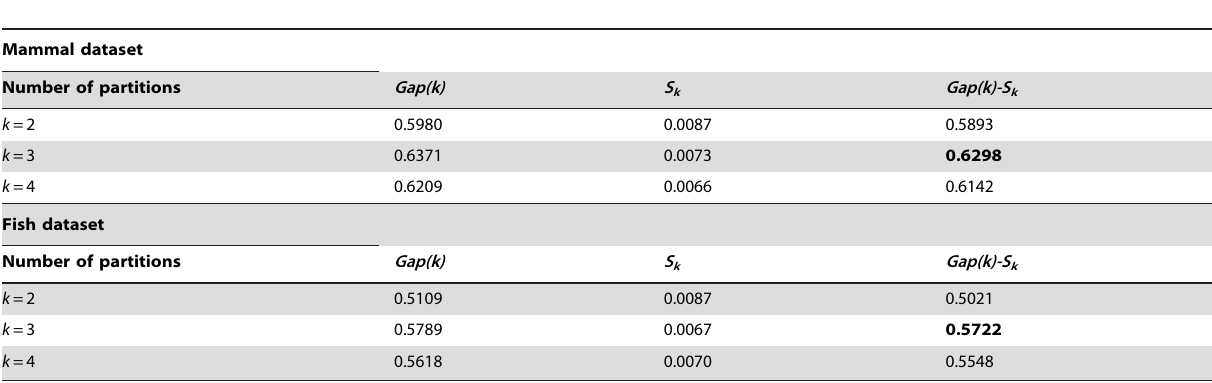
Table 2. Gap(k) and S k statistics for the mammal and fish mitochondrial datasets.